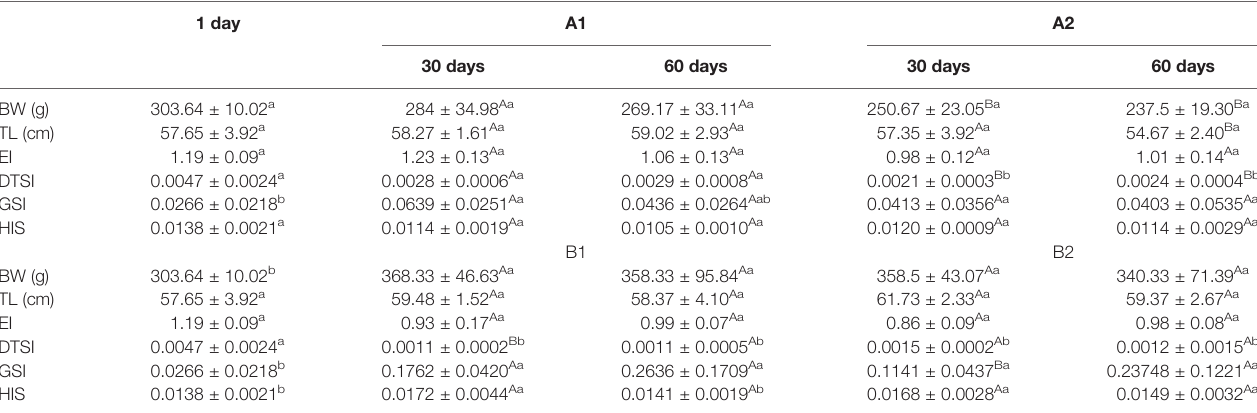
TABLE 1 | Effects of swimming and hormone injection on body indexes of conger